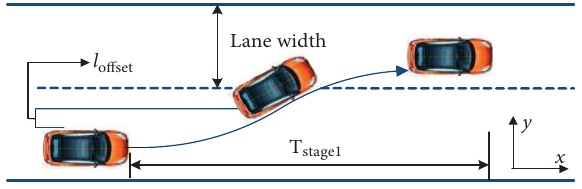
Figure 3: SV lane change